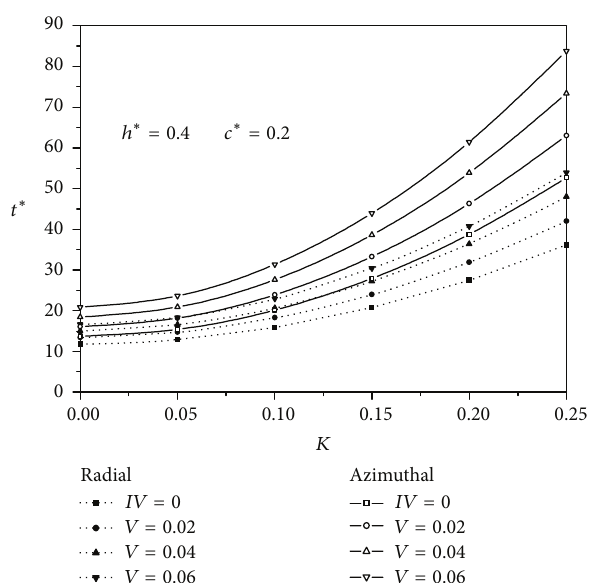
Figure 6: Dimensionless time 𝑡 ∗ versus non-Newtonian parameter 𝐾 for different 𝑉 .